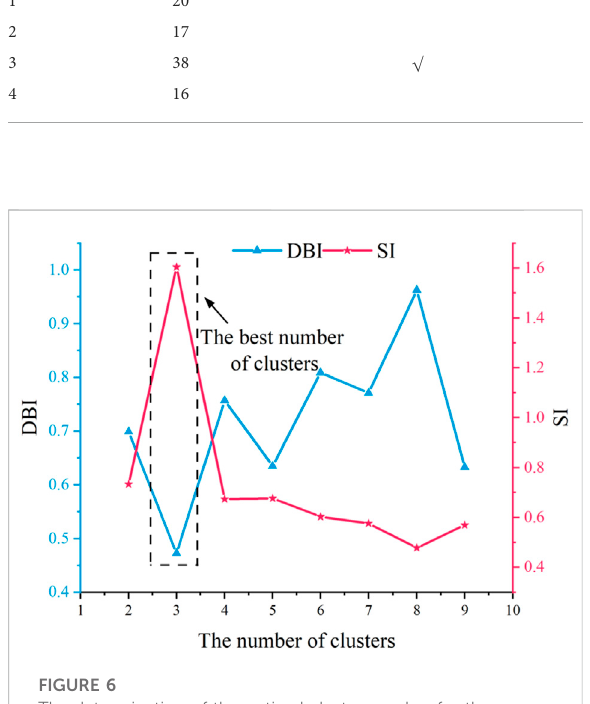
FIGURE 6 The determination of the optimal cluster number for the users ’